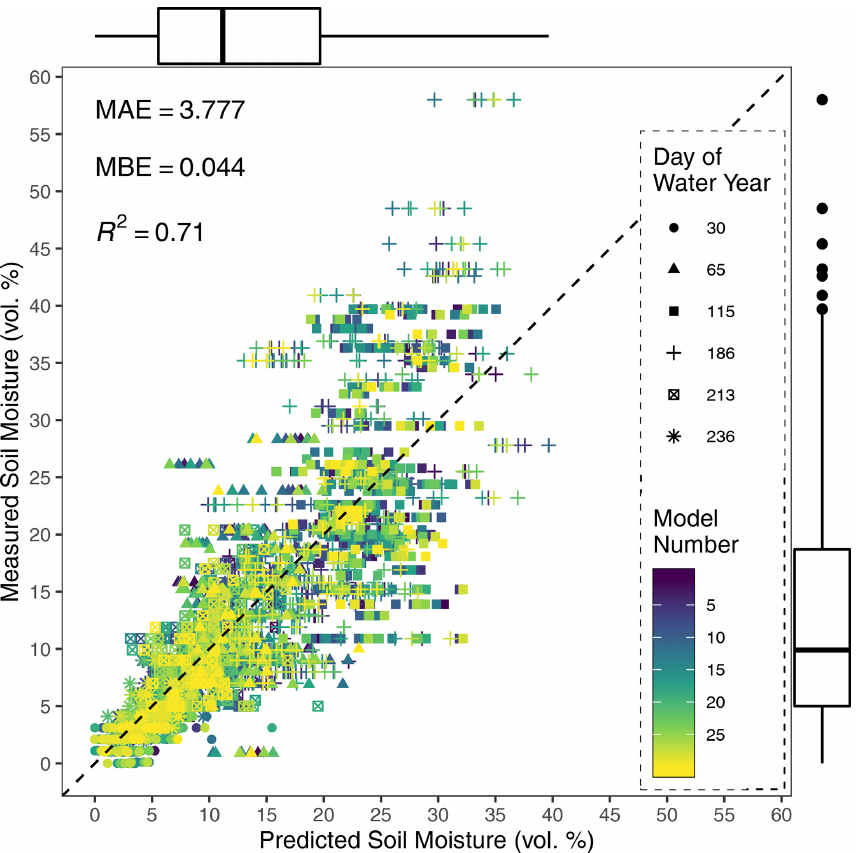
Figure 7. Scatterplot of the measured vs. predicted soil moisture content for the testing sets. Marginal box plots show the distributions of measured and predicted values. MAE, MBE, and R 2 are averaged across the 30 models.